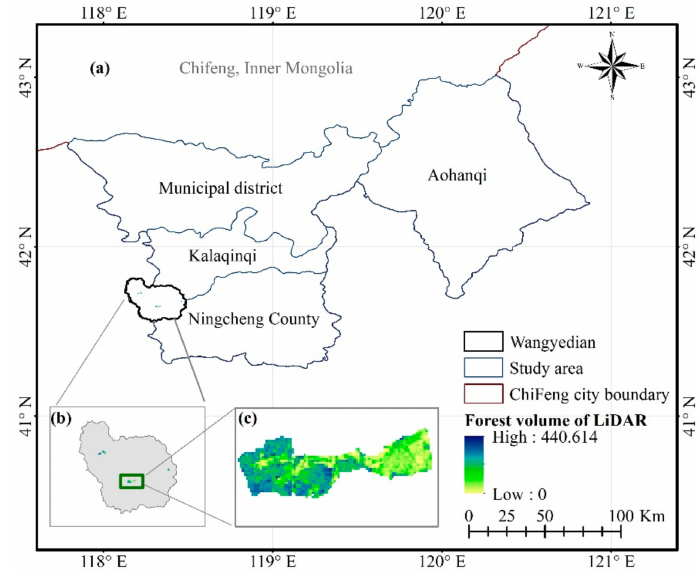
Figure 1. The study area, covering four administrative regions, located in Chifeng, Inner Mongolia (a, b, and c denote the study area, Wangyedian forest district in which the LiDAR scanning result located, and partial enlargement of LiDAR data